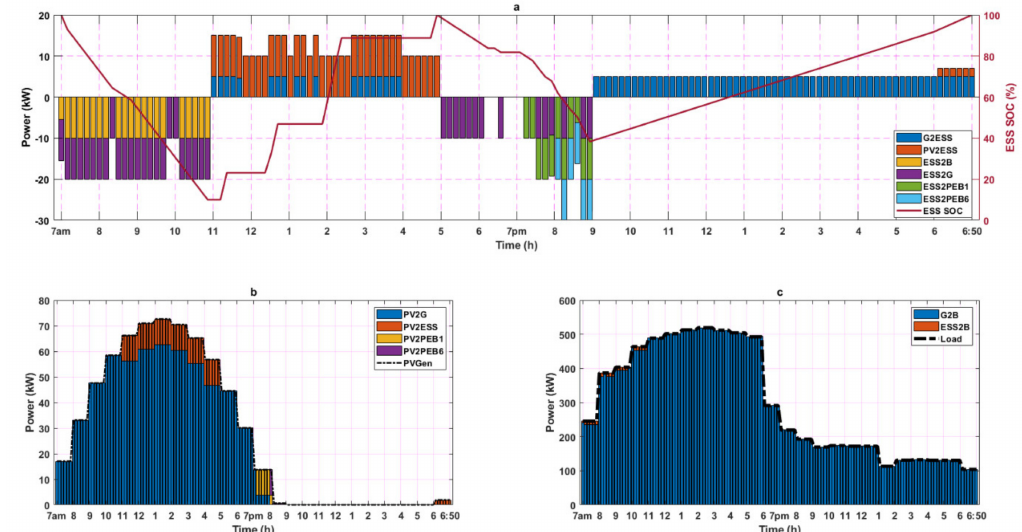
Figure 7. (a) SOC of ESS in a single day; (b) PV generation and supply; and (c) building load demand and